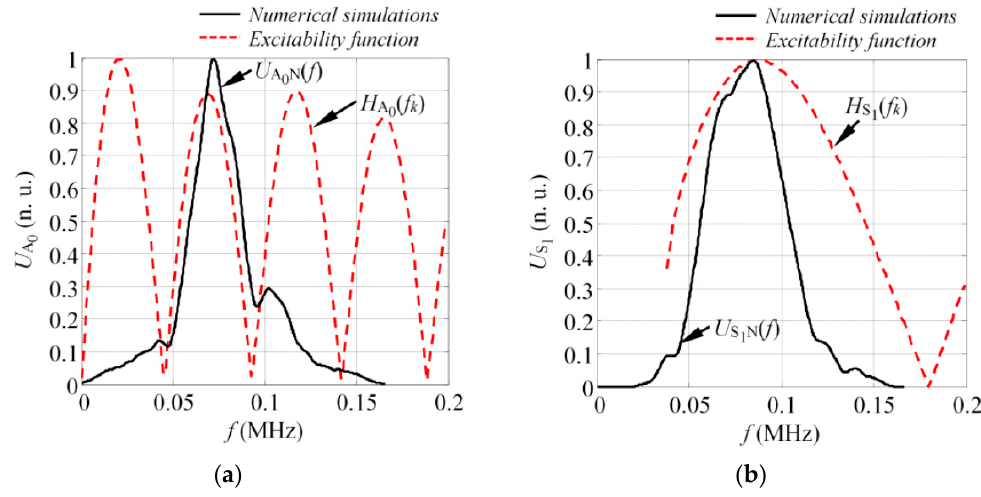
Figure 9. The numerically estimated frequency spectra of the pure A 0 ( a ) and S 1 ( b ) mode on a 4 mm GFRP sample (solid line) along with analytically predicted excitability functions (dashed line).